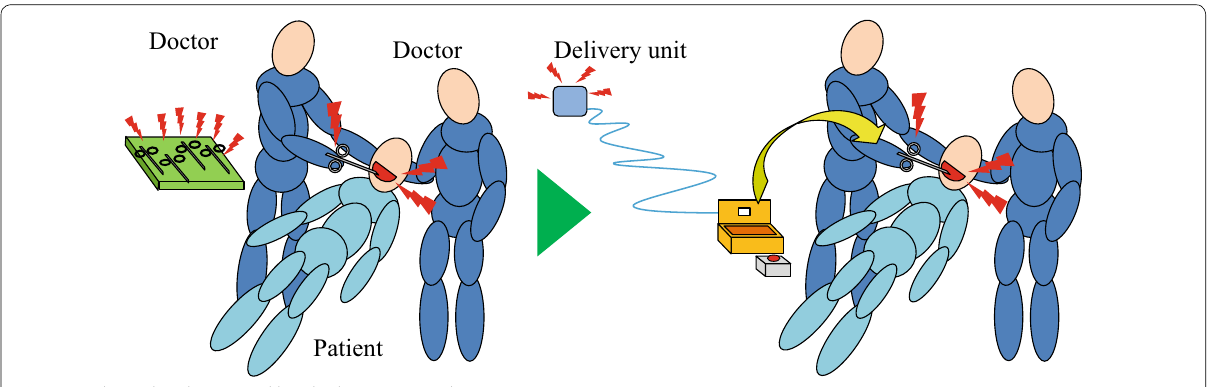
Fig. 3 Traditional and proposed brachytherapy procedures